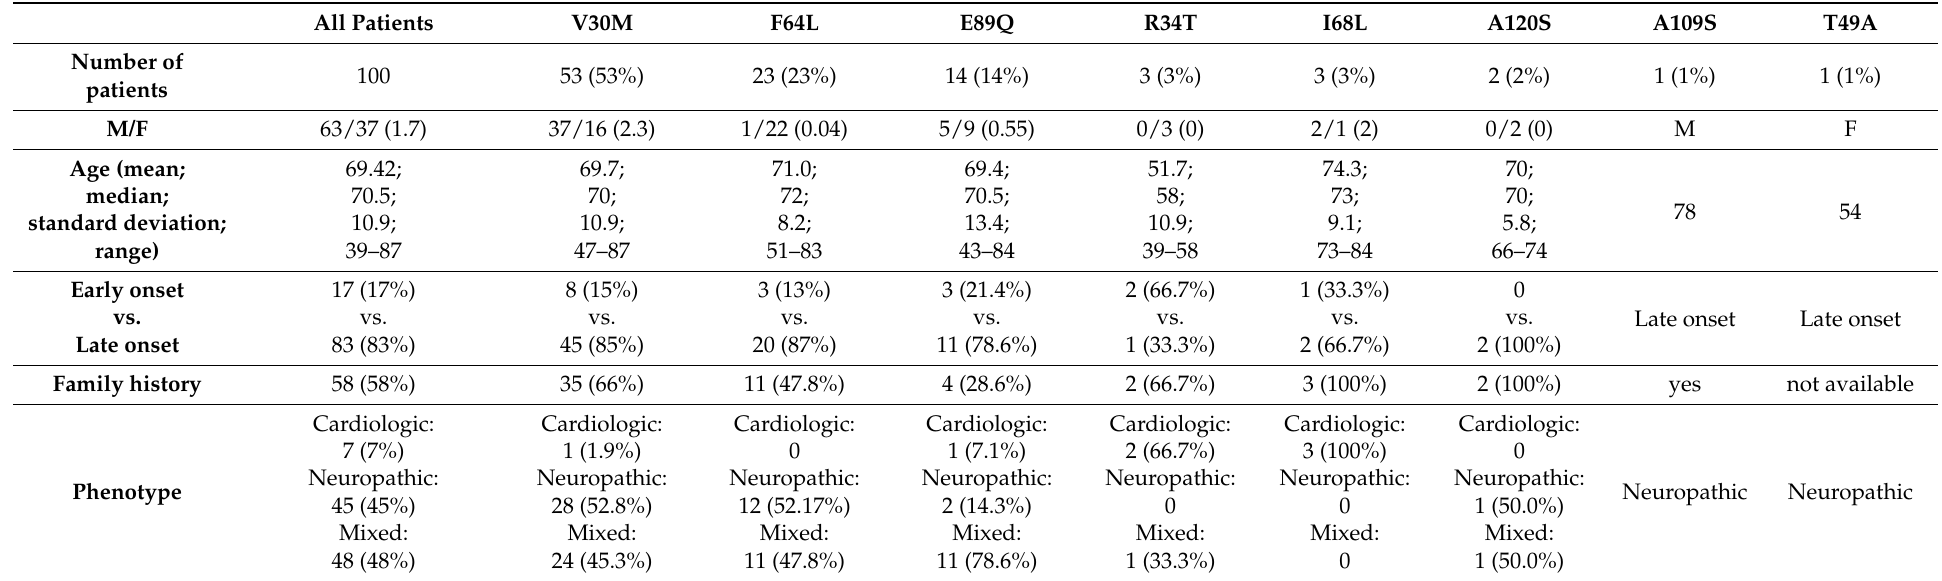
Table 1. Demographic and clinical characteristics of hATTR Lazio